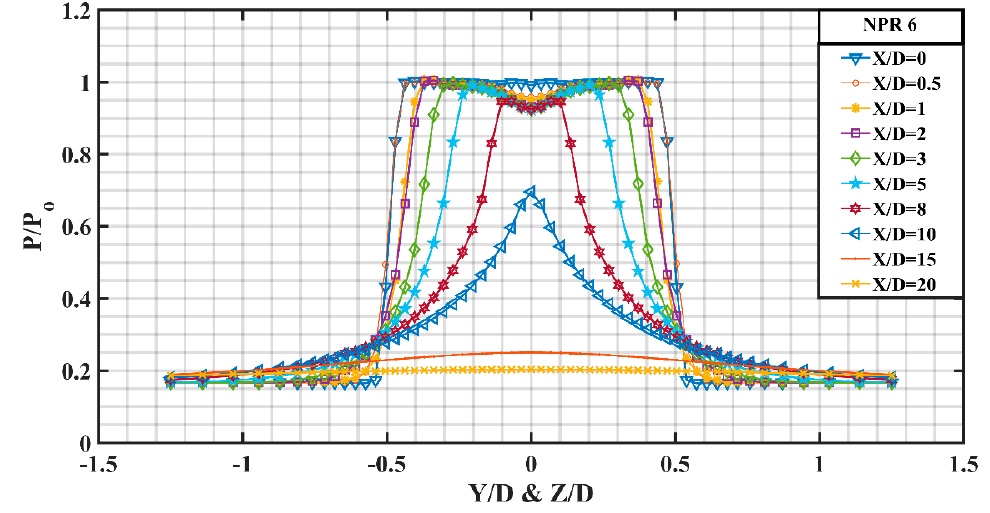
Figure 20. Pressure profile variation for uncontrolled jet at NPR 6.